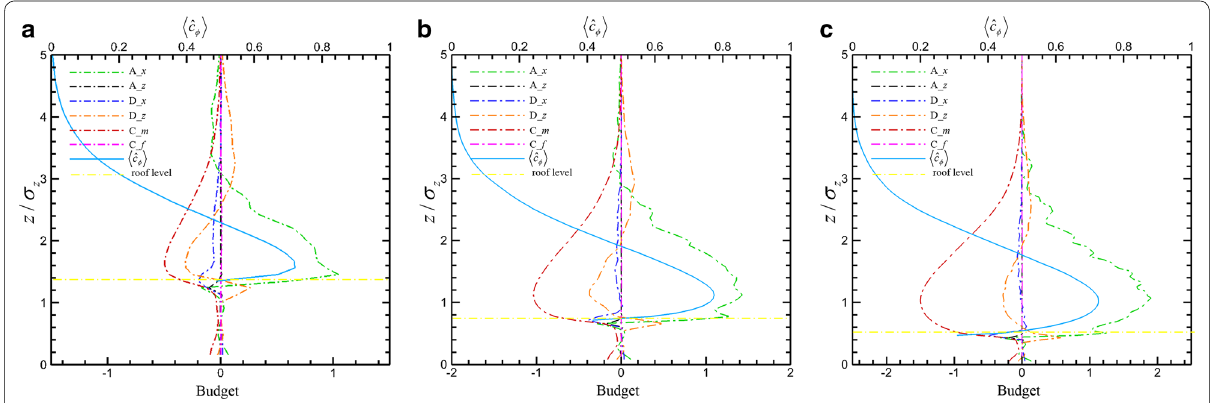
Fig. 4 Budget analysis and vertical profiles of NO concentration in the streamwise direction at a x / h